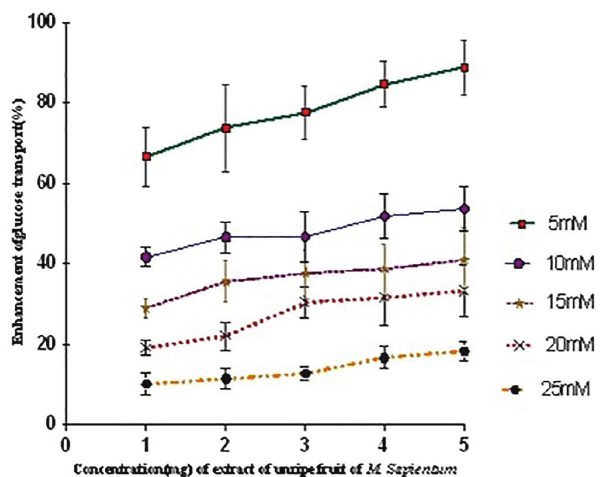
FIGURE 2 - Effect of extract of unripe fruit of Musa sapientum on the uptake of glucose by yeast cells. (Values are mean ± SD of triplicate